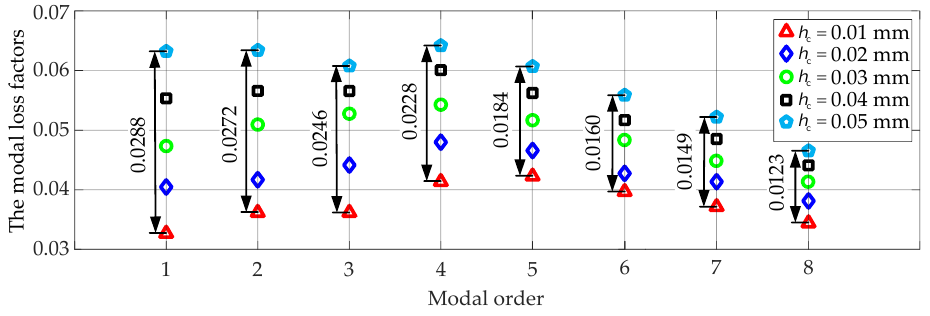
Figure 8. The variation rate of resonant response of the composite shell corresponding to different thicknesses of hard coating.